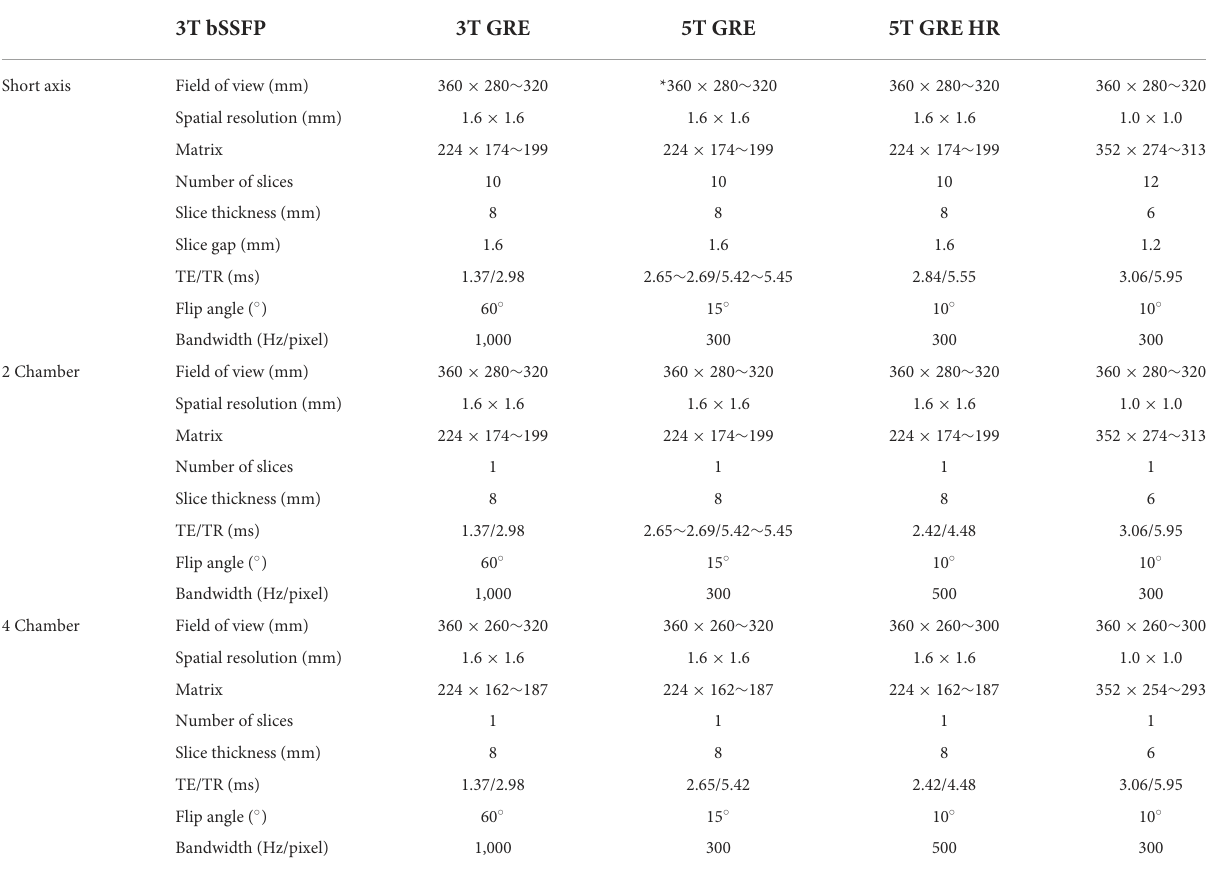
TABLE 1 CMR scanning parameters in this